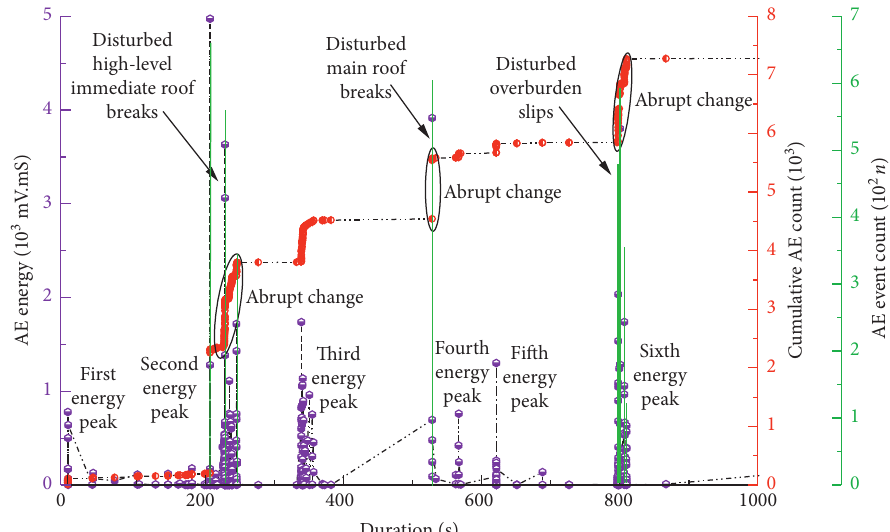
Figure 6: Relationship between disturbed overburden breaking and slipping AE parameters and